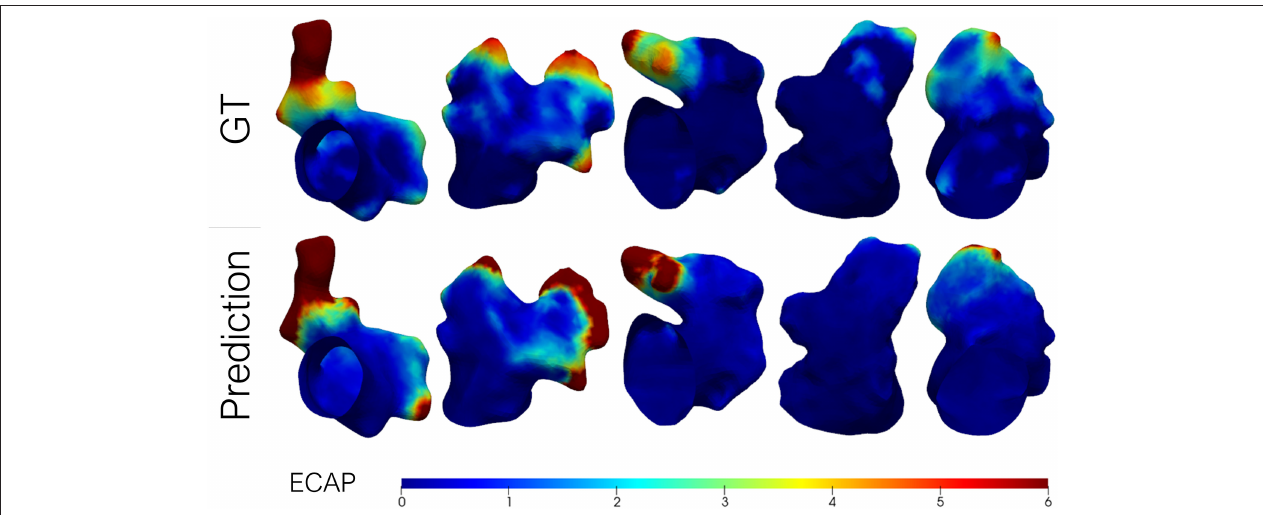
FIGURE 7 | Predicted endothelial cell activation potential (ECAP) maps in a batch of left atrial appendages (LAA) from dataset 2 (i.e., patient-specific LA) alongside the ground-truth (GT) from fluid simulations. Higher ECAP values (in red) are linked to a higher risk of thrombus